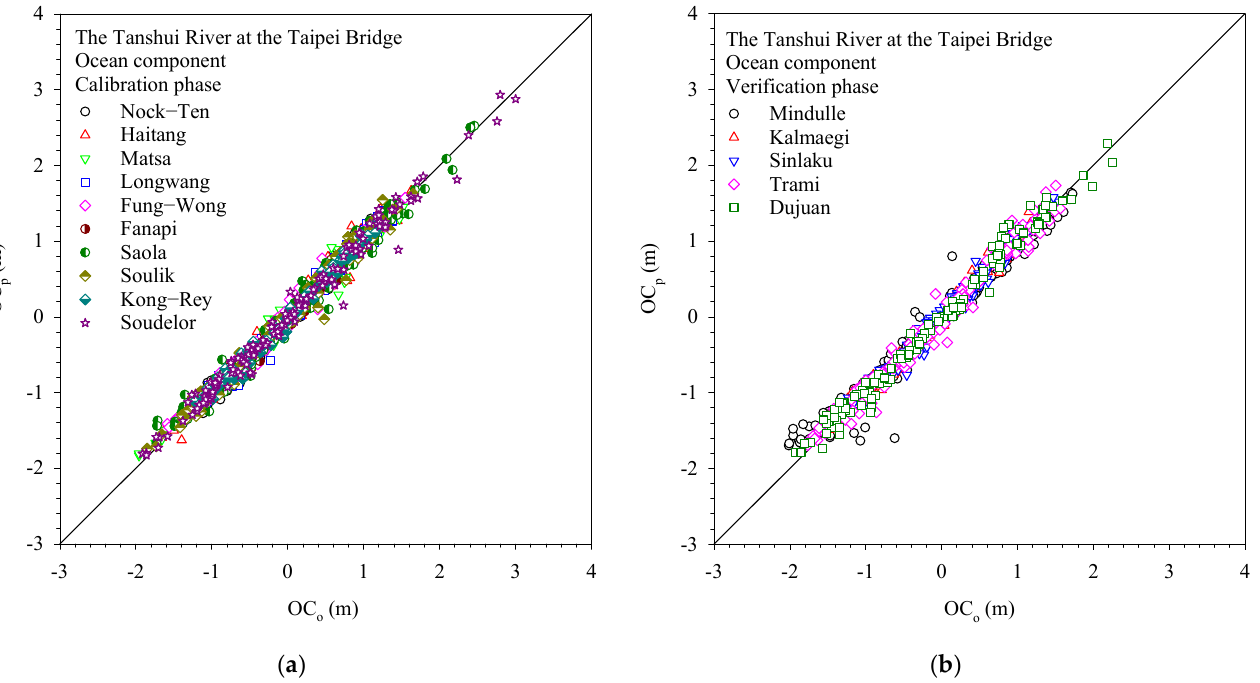
Figure 7. Accuracy of 1 h ahead ocean component forecasting during typhoons: ( a ) calibration phase; ( b ) Verification phase.